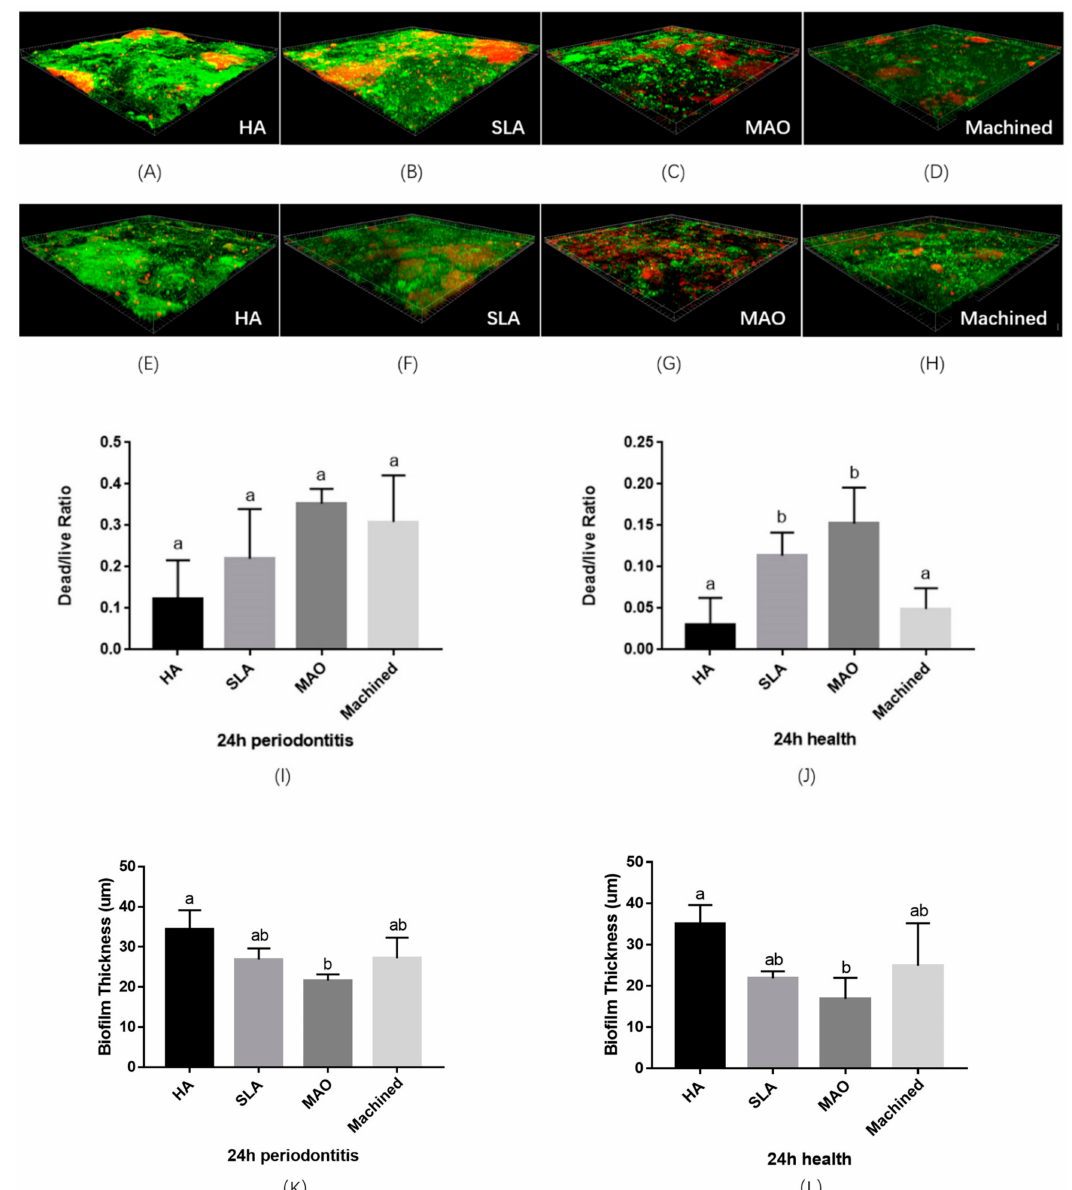
Figure 4. Confocal laser scanning microscope (CLSM) of saliva-derived biofilms. Live / dead staining of biofilms on titanium discs in the four groups. Live cells are stained green, whereas dead cells are stained red. ( A , B , C , D ) Periodontitis HA, SLA, MAO, and machined; ( E , F , G , H ) healthy HA, SLA, MAO, and machined; ( I ) live / dead ratio of periodontitis; ( J ) live / dead ratio of health; ( K ) biofilm thickness of periodontitis; and ( L ) biofilm thickness of healthy sample. Significant di ff erences between bars are marked with di ff erent letters (a, b) ( p <